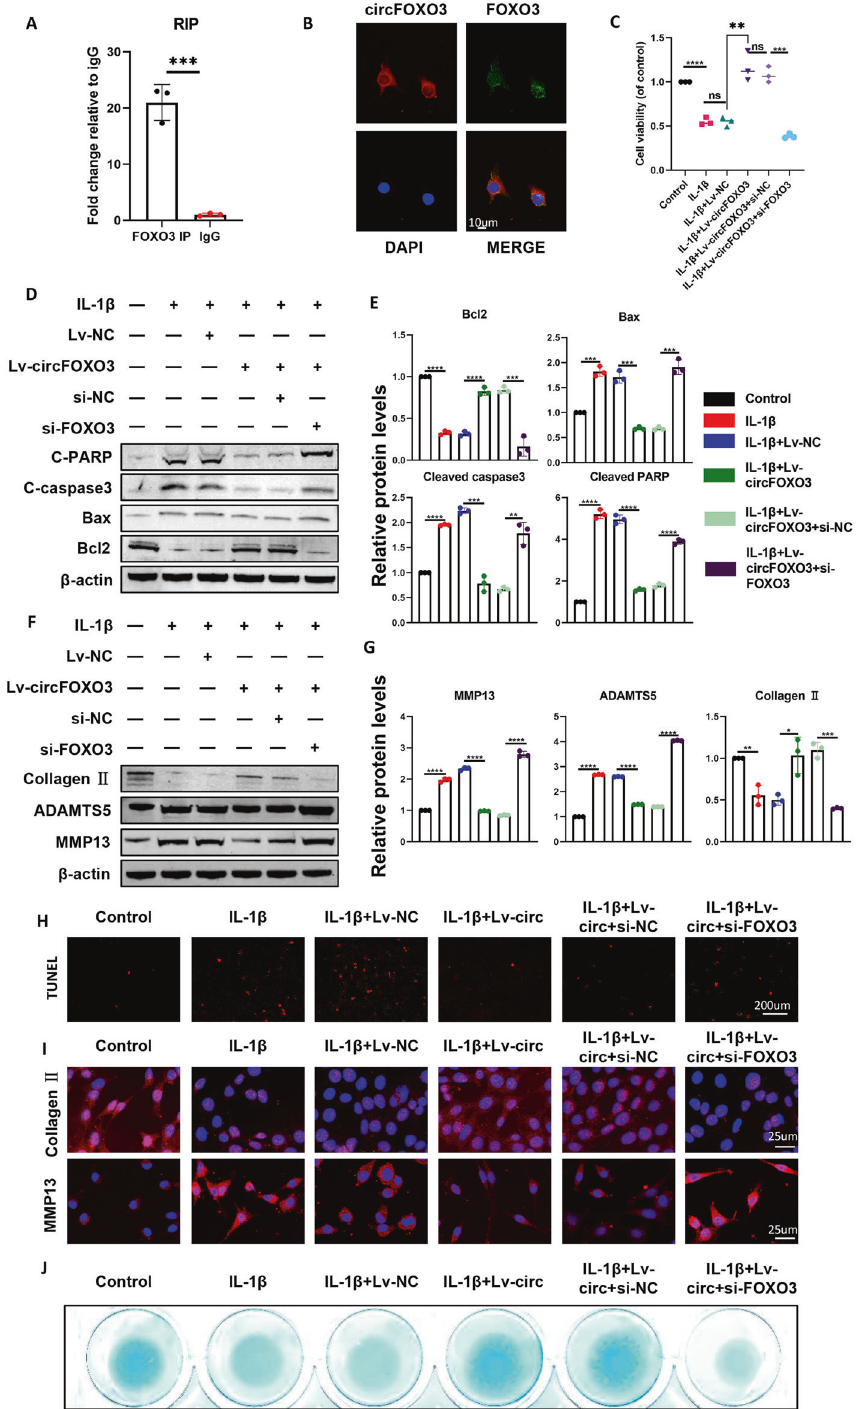
Fig. 4 The regulation of circFOXO3 on osteoarthritis is FOXO3-dependent. A RIP assay was performed to detect circFOXO3 levels in ATDC5 cells stably expressing FOXO3. ( n = 3) *** p < 0.001. B Representative images of circFOXO3 (red) and FOXO3 (green) labeled fl uorescence in situ hybridization (FISH) staining. Scale bar, 10 µm. C Cell viability determined by CCK-8 assay. ( n = 3) ** p < 0.01, *** p < 0.001, **** p < 0.0001. D , E Western blot analysis of Cleaved PARP, Cleaved caspase-3, Bax and Bcl2 when Lv-circFOXO3 and si-FOXO3 were co-transfected. The optical density analysis was performed from the results of three independent experiments of western blot samples. *** p < 0.001, **** p < 0.0001. F , G Western blot analysis of MMP13, ADAMTS5 and Collagen II when Lv-circFOXO3 and si-FOXO3 were co-transfected. The optical density analysis was performed from the results of three independent experiments of western blot samples. * p < 0.05, ** p < 0.01, *** p < 0.001, **** p < 0.0001. H TUNEL staining assay was conducted on the ATDC5 chondrocytes, as treated above. Scale bar, 200 µm. I Immuno fl uorescence staining of MMP13 and collagen II in ATDC5 chondrocytes as treated above. Scale bar, 25 µm. J Alcian blue staining of Lv-circFOXO3 and si-FOXO3 co-transfected ATDC5 chondrocytes.